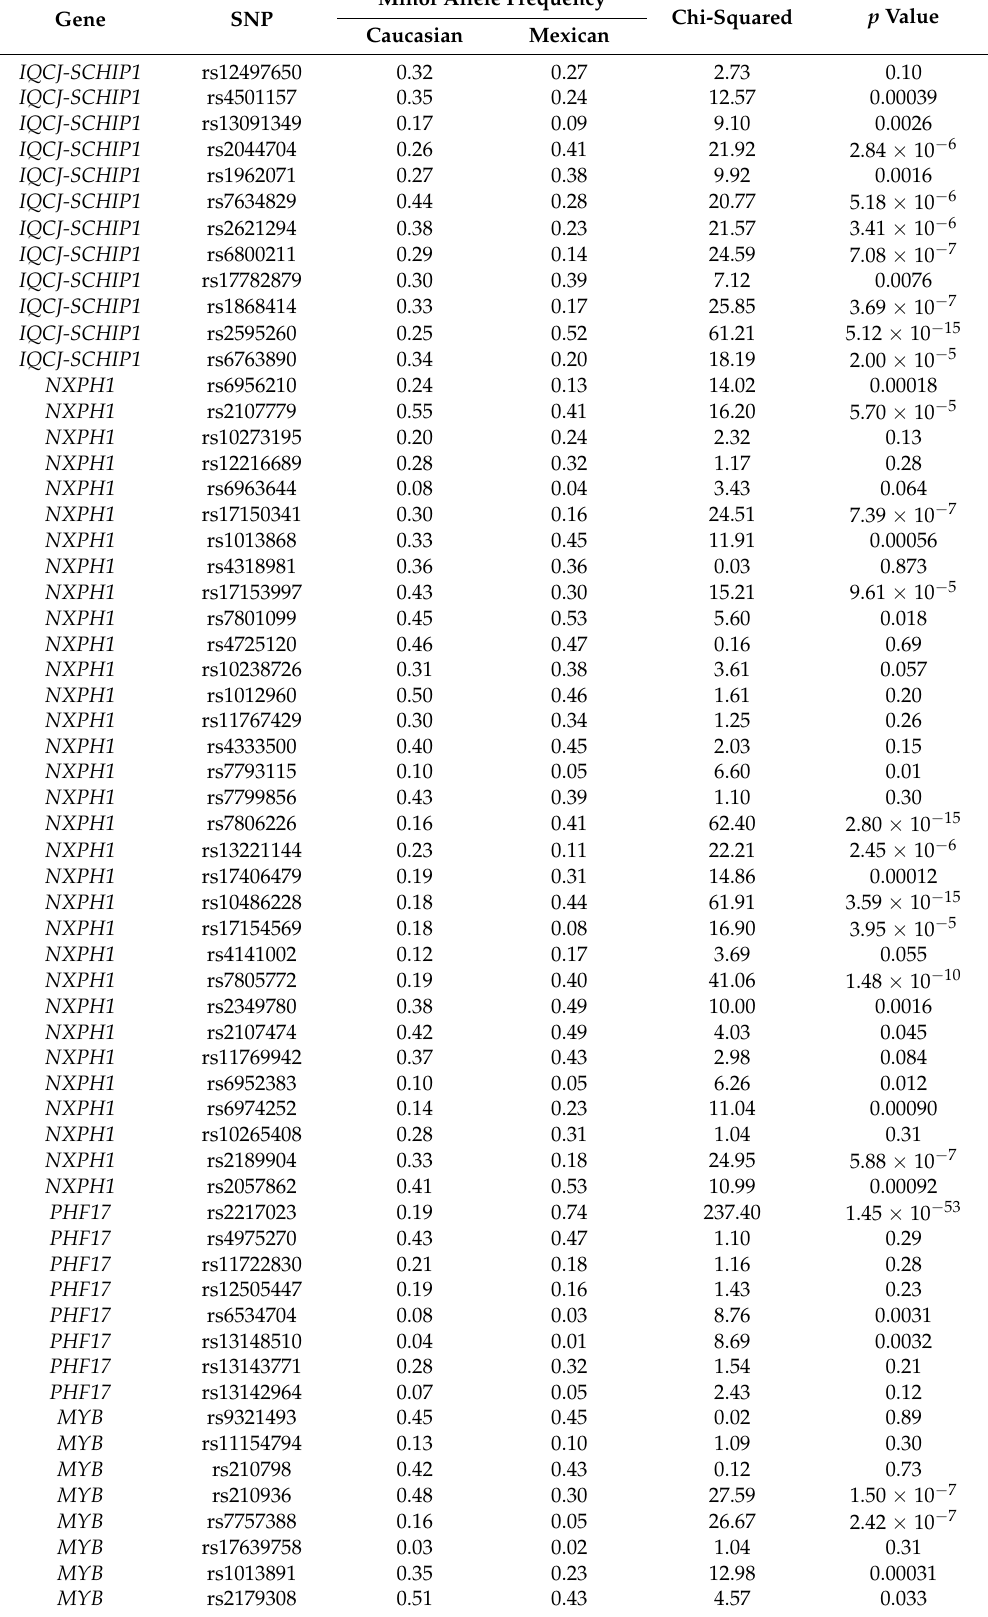
Table 2. Comparison of allele frequency between French Canadian Caucasians and Mexicans. Gene SNP